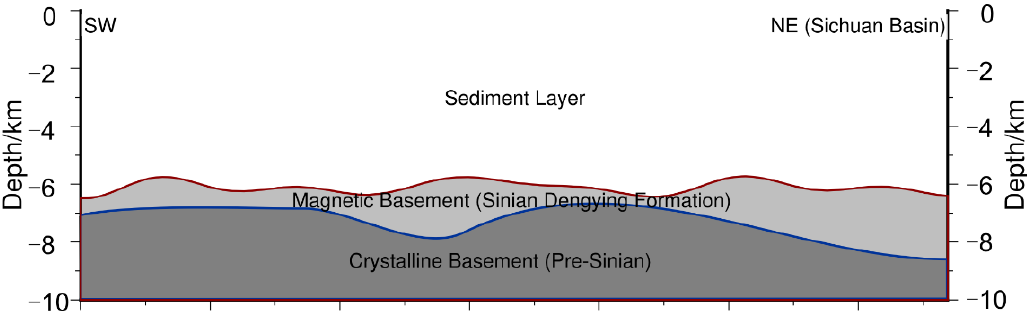
Figure 8. Sketch of magnetic basement structure along the profile AA’ in the Changning area.